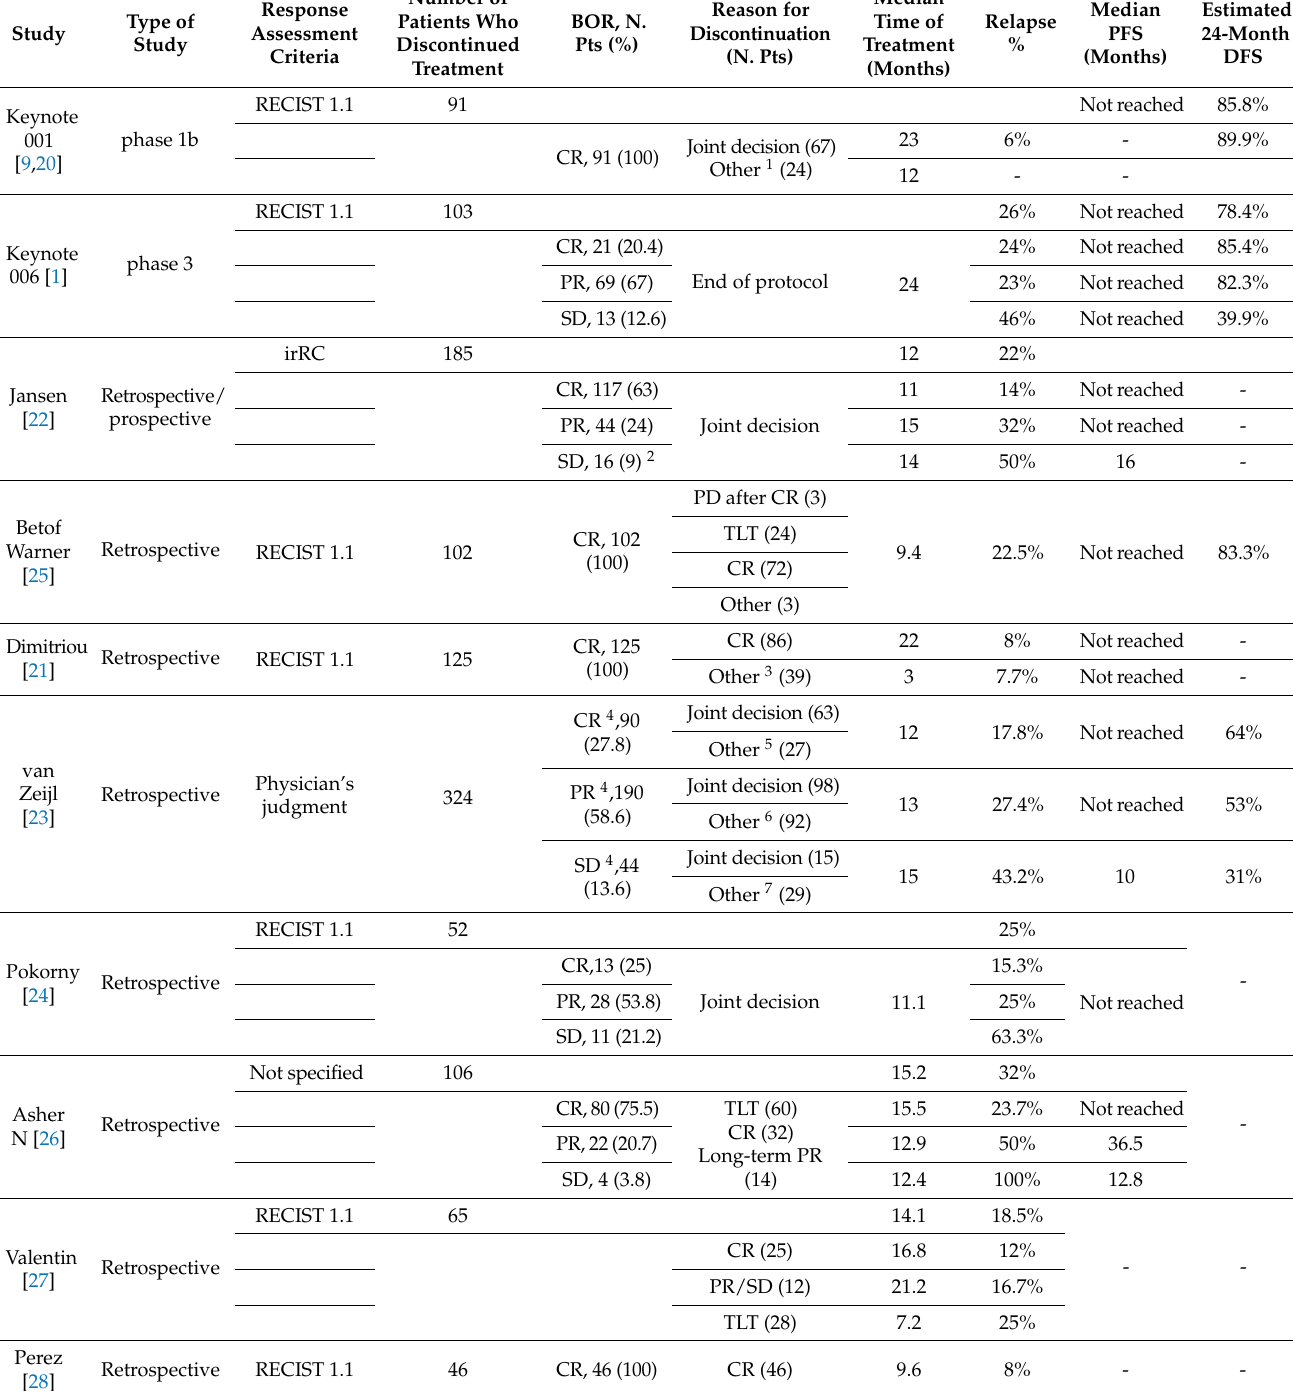
Table 1. Type of study and clinical